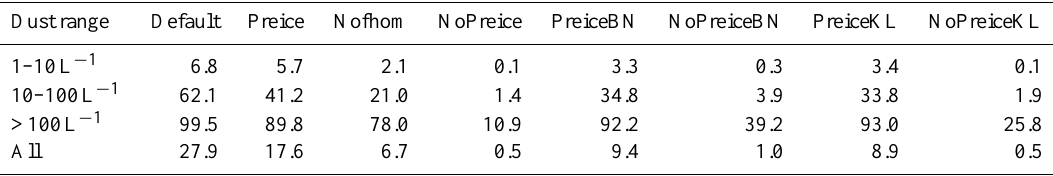
Table 4. All percentage contributions from heterogeneous ice nucleation to total ice crystal number concentration (in unit of %) within different ranges of dust number concentration for all present-day simulations. Model results are sampled every 3h. Only ice nucleation occurrence events are